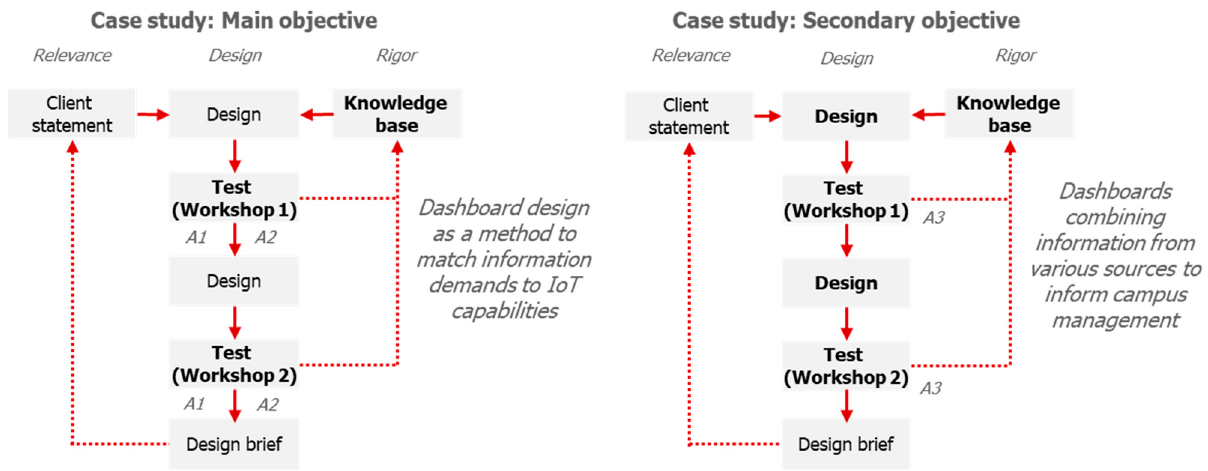
Figure 3. Research design for one case, displayed twice to show the relationship between the analyses and main and secondary objectives. The resulting design brief answers the client statement. The analyses of the testing phase inform the knowledge base. A1, A2 and A3 denote the three analyses reported in the paper. Emphasis in bold denotes relevance to each objective.